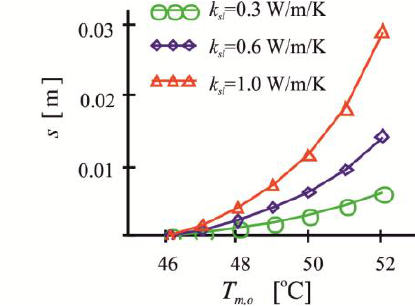
Fig. 3. Thickness of the sludge layer, s = s ( T m.o , k sl ), versus outlet temperature of the heating medium, at a constant supply temperature and for different heat conduction